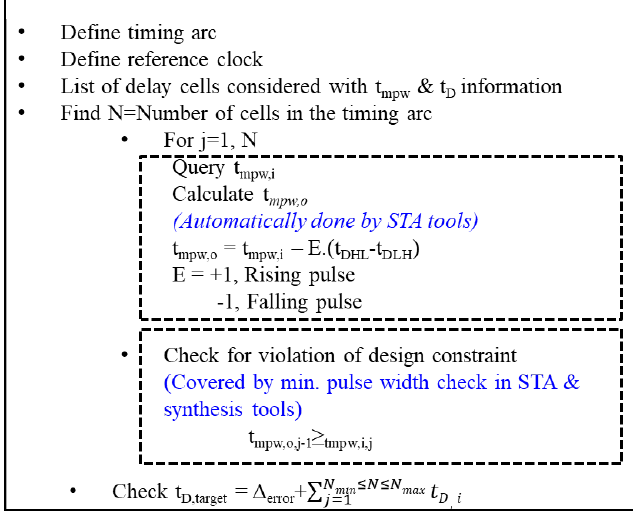
Figure 11. Custom STA